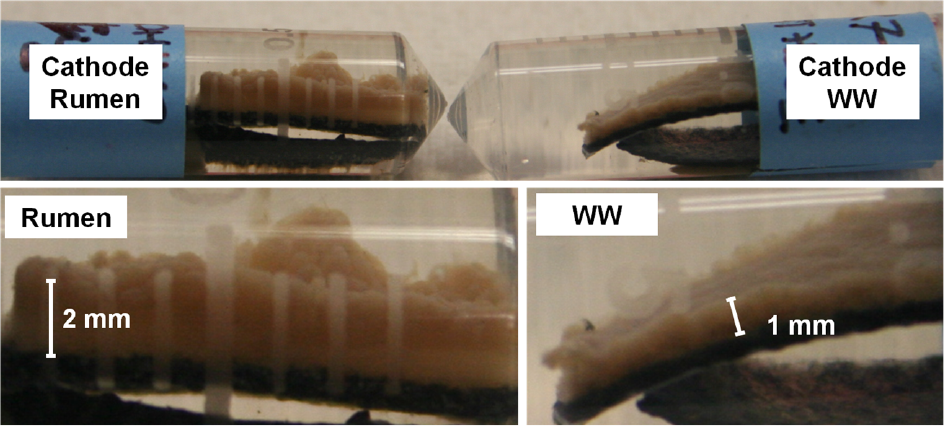
Figure 4. Photographs of biofilm formed on air-cathodes after over 60 days of operation. Bottom panels are a magnification of the top panel (WW: wastewater).